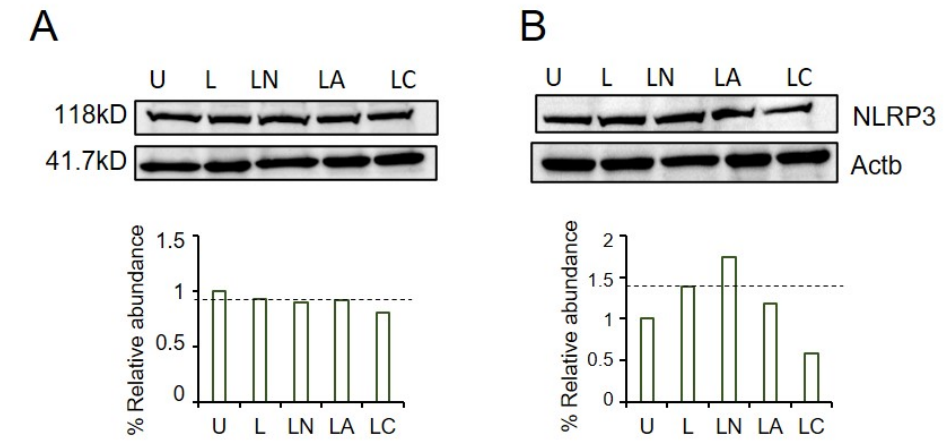
Figure 4. The effect of LPS-Az and LPS-Cf on NLRP3 protein in ( A ) A549 and ( B ) PC3 cells. U: Untreated, L: LPS, LN: LPS-ng, LA: LPS-Az, LC: LPS-Cf. Dotted line indicates the relative NLRP3 protein expression in LPS primed cells. Western blots were visualized using ChemiDoc XRS Plus (Bio-Rad, Hercules, CA, USA). Protein levels were quantified using ImageJ v1.53s software (National Institutes of Health, Bethesda, MD, USA).